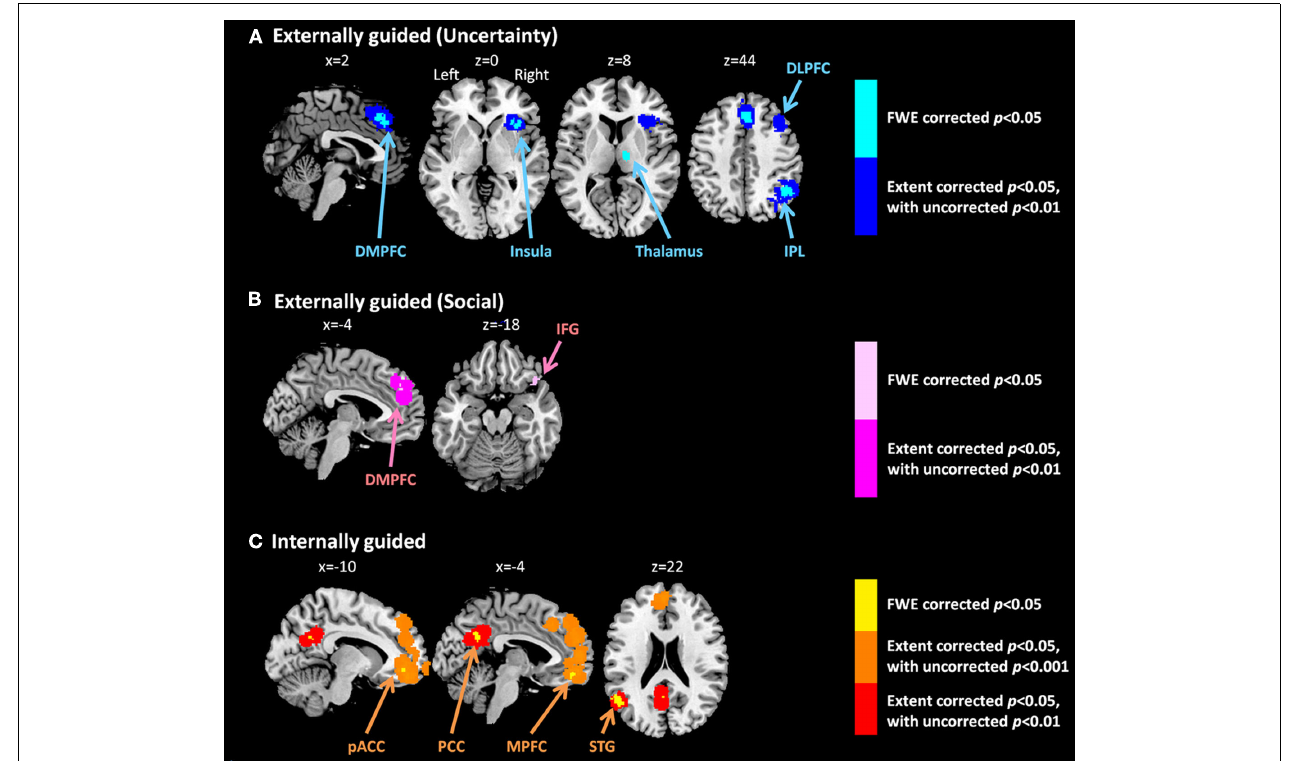
threshold of FWE corrected for the spatial extent at p < 0.05 with primary thresholds of uncorrected p < 0.01. No clusters were identified at the stringent threshold in externally guided decision-making under uncertainty or in a social situation. DMPFC, dorsomedial prefrontal cortex; DLPFC, dorsolateral prefrontal cortex; IPL, inferior parietal lobule; IFG, inferior frontal gyrus; pACC, perigenual anterior cingulate cortex; PCC, posterior cingulate cortex; MPFC, medial prefrontal cortex.; STG, superior temporal